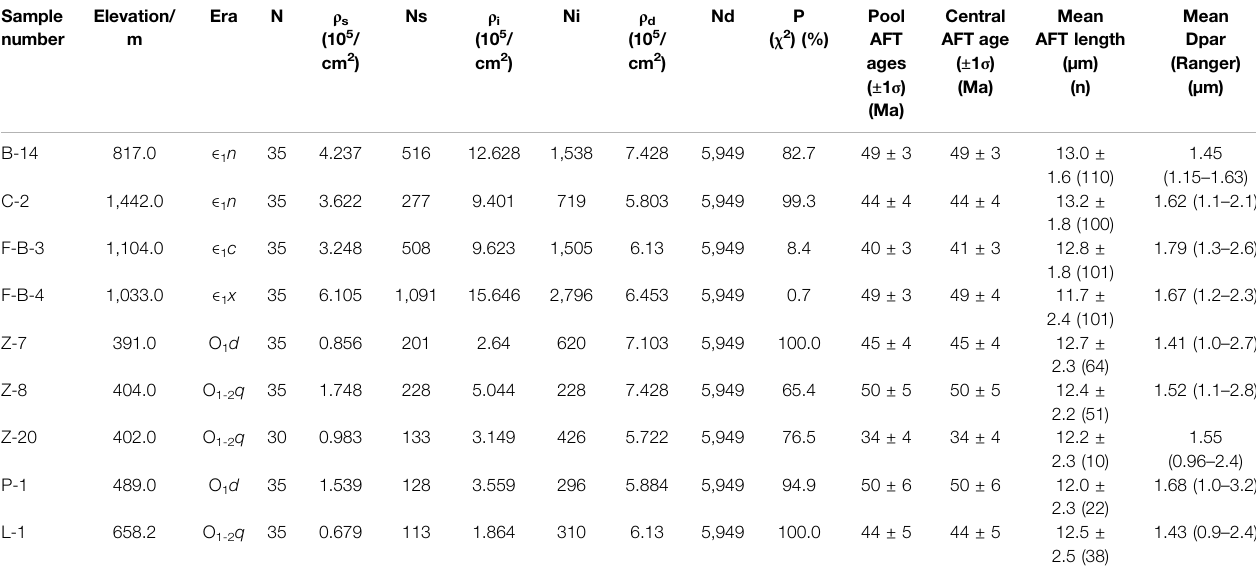
TABLE 2 | Results of AFT analysis in the Micangshan and Dabashan